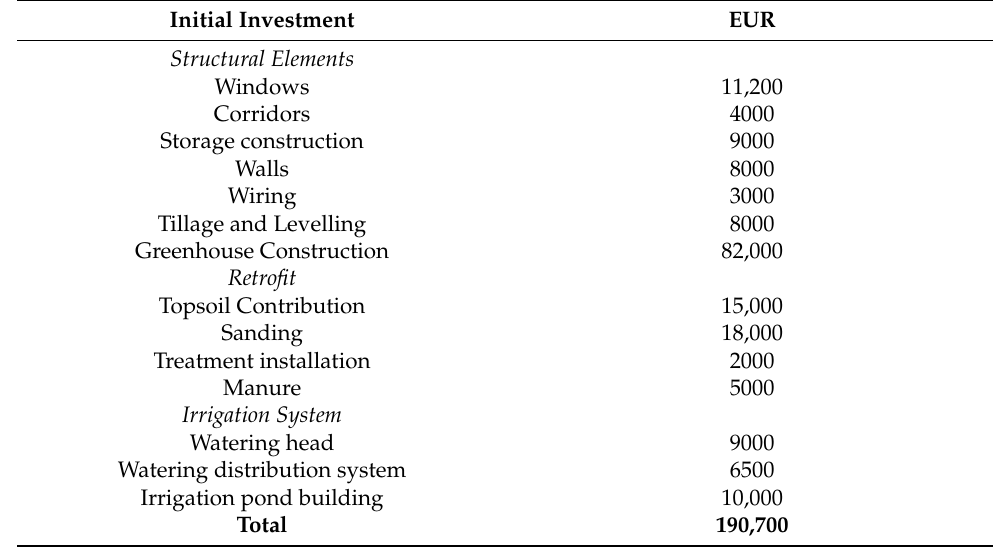
Table 3. Initial Investment for a Greenhouse Hectare.